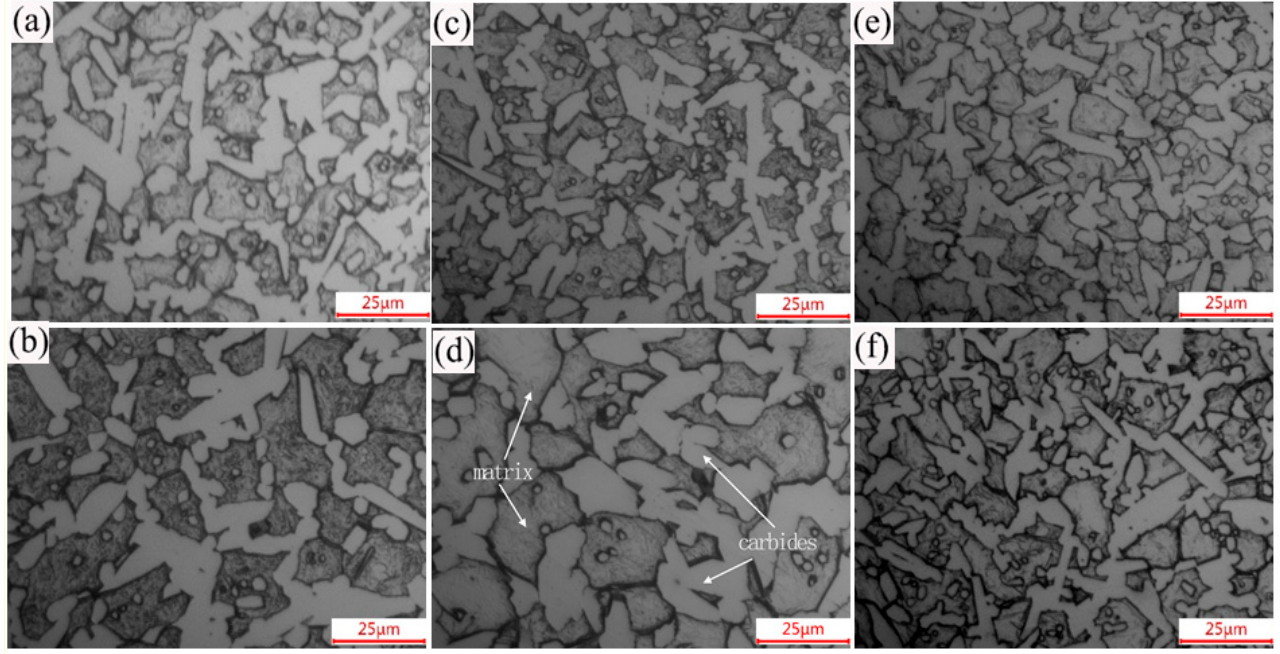
Figure 5. OM images of microstructures. ( a ) #1, ( b ) #2, ( c ) #3, ( d ) #4, ( e ) #5, and ( f ) #6. Table 4. The statistical results of OM images.